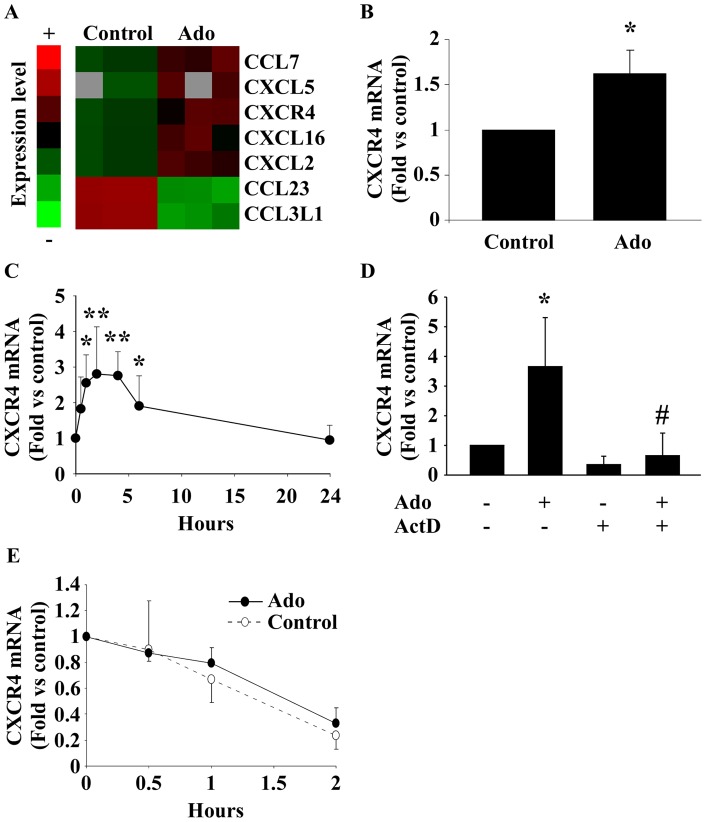
Adenosine increases CXCR4 mRNA expression.A. Transcriptomic analysis of EPC treated with 10 µmol/L Ado for 6 hours using microarrays. The heat map indicates chemokines and chemokine receptors differentially expressed following Ado treatment (all with q values ≤0.001). B. Confirmation of CXCR4 over-expression in EPC treated by 10 µmol/L Ado for 6 hours using quantitative PCR. Expression values were normalized to β-actin and to untreated cells. * P<0.05 vs control (n = 3). C. Kinetic of the effect of Ado on CXCR4 mRNA expression. * P<0.05 vs control. ** P<0.001 vs control. P<0.001 using ANOVA (n = 5). D. Effect of actinomycin D (ActD). EPC were pre-treated by 5 µg/mL ActD for 30 min before treatment with 10 µmol/L Ado. CXCR4 mRNA expression was assessed after 2 hours. * P<0.01 vs control. # P<0.01 vs Ado (n = 3). E. EPC were pre-treated with ActD (5 µg/mL) for 30 min and were incubated with Ado for different time periods (30 min, 1 h and 2 h) before assessment of CXCR4 mRNA by PCR (n = 4).